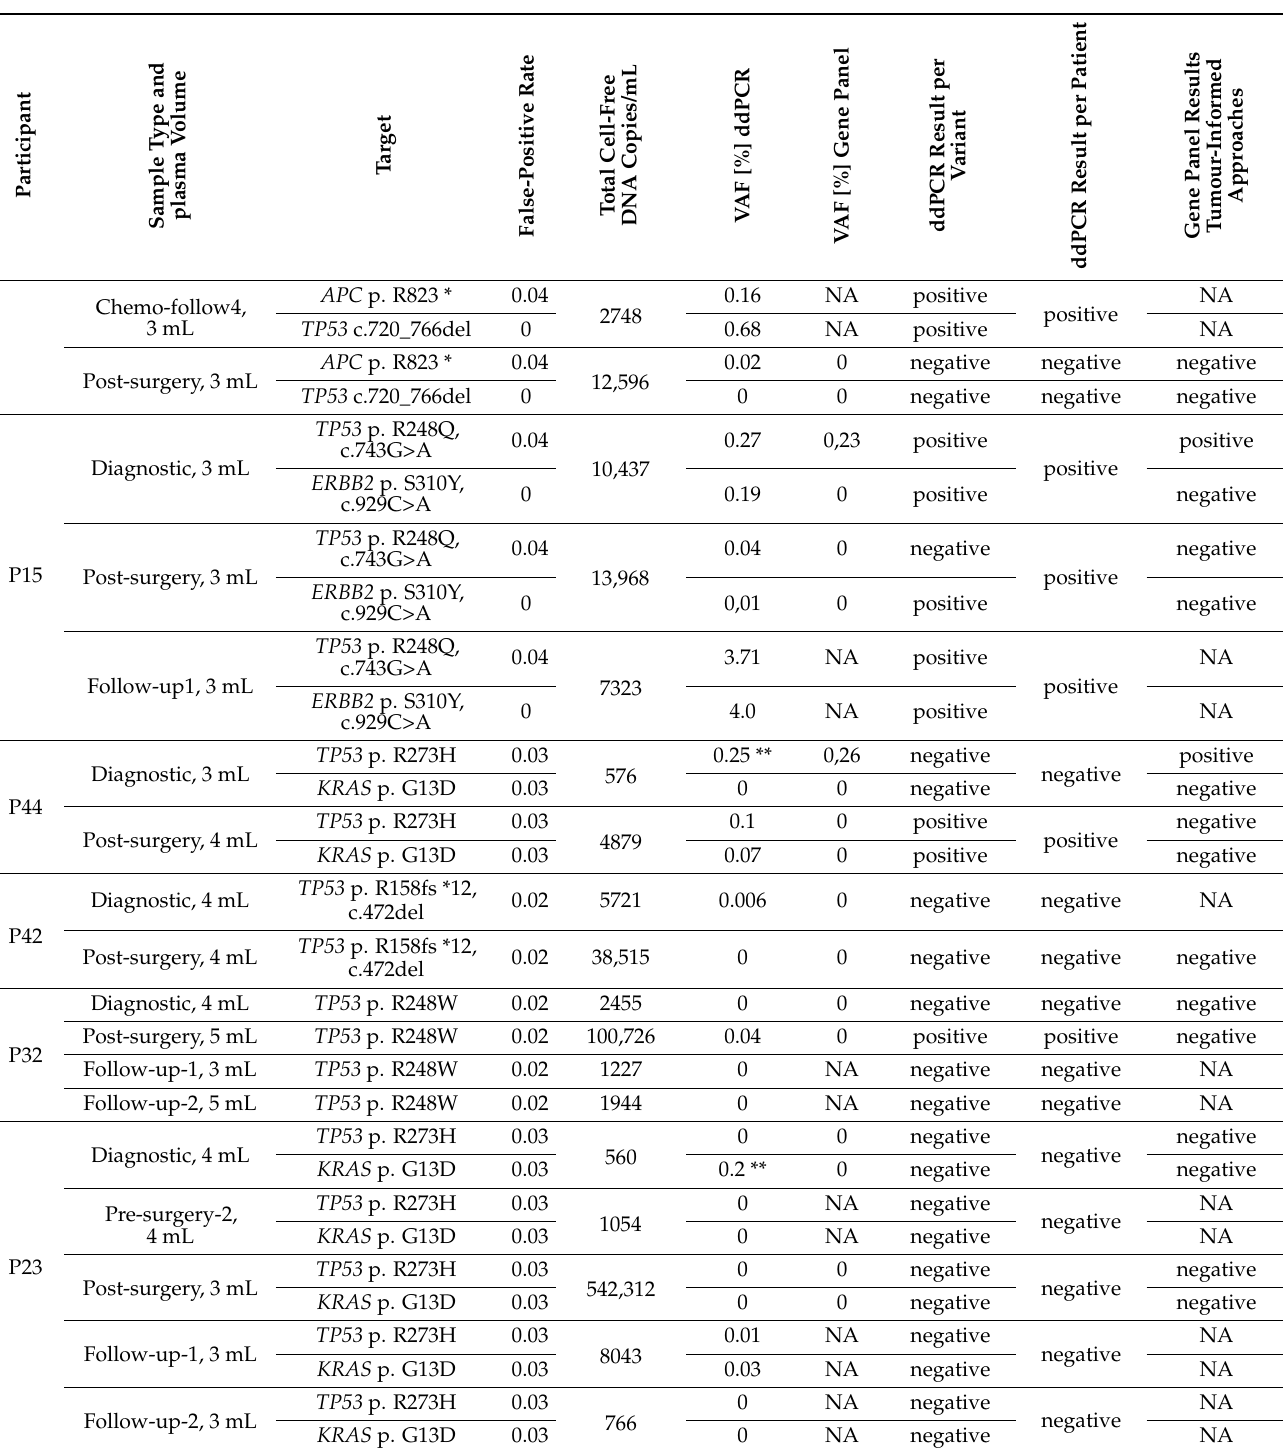
Table 3 Legend: Detection results from ddPCR for each plasma sample in 12 participants for each target assay. When ctDNA was detected, it is considered positive. The last column includes the results from the cell-free DNA analysis by gene panel sequencing. The volumes of plasma used for each reaction are presented in the second column. * truncating, ** Determined negative because of overlapping error bars with the negative